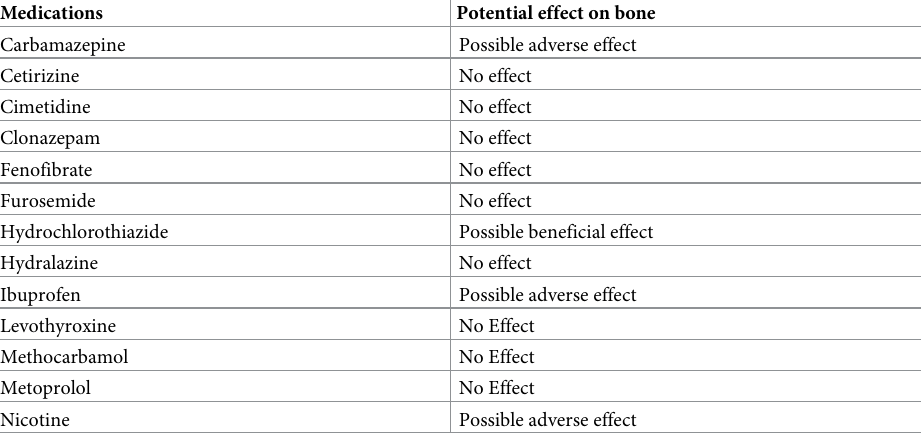
Table 3. Potential effects of medications on